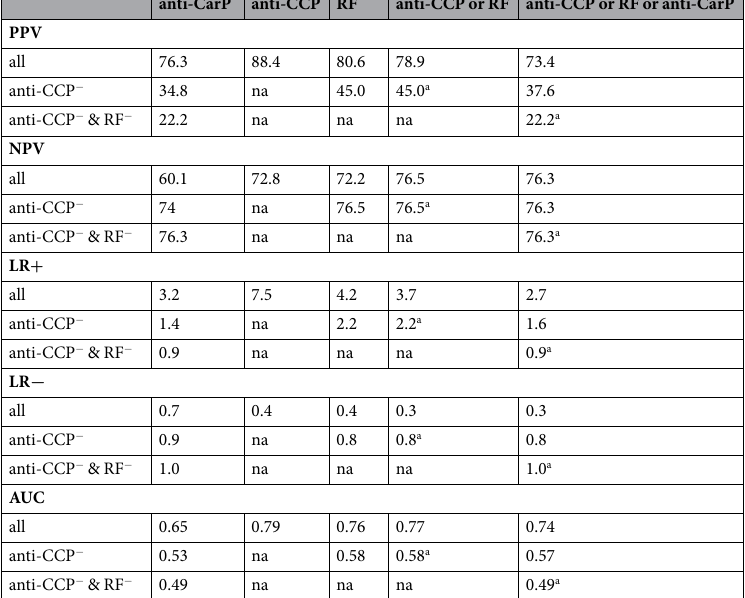
Table 3. Additional parameters assessing the diagnostic value of the antibodies and their combination. All refers to all RA patients, the other rows refer to the indicated subset of RA patients. a Values already presented in the table to the right, but duplicated to facilitate comparison. PPV = positive predictive value, NPV = negative predictive value, LR + = likelihood ratio of a positive finding, LR − = likelihood ratio of a negative finding and AUC = area under the Receiver Operating Curve. na = not applicable.